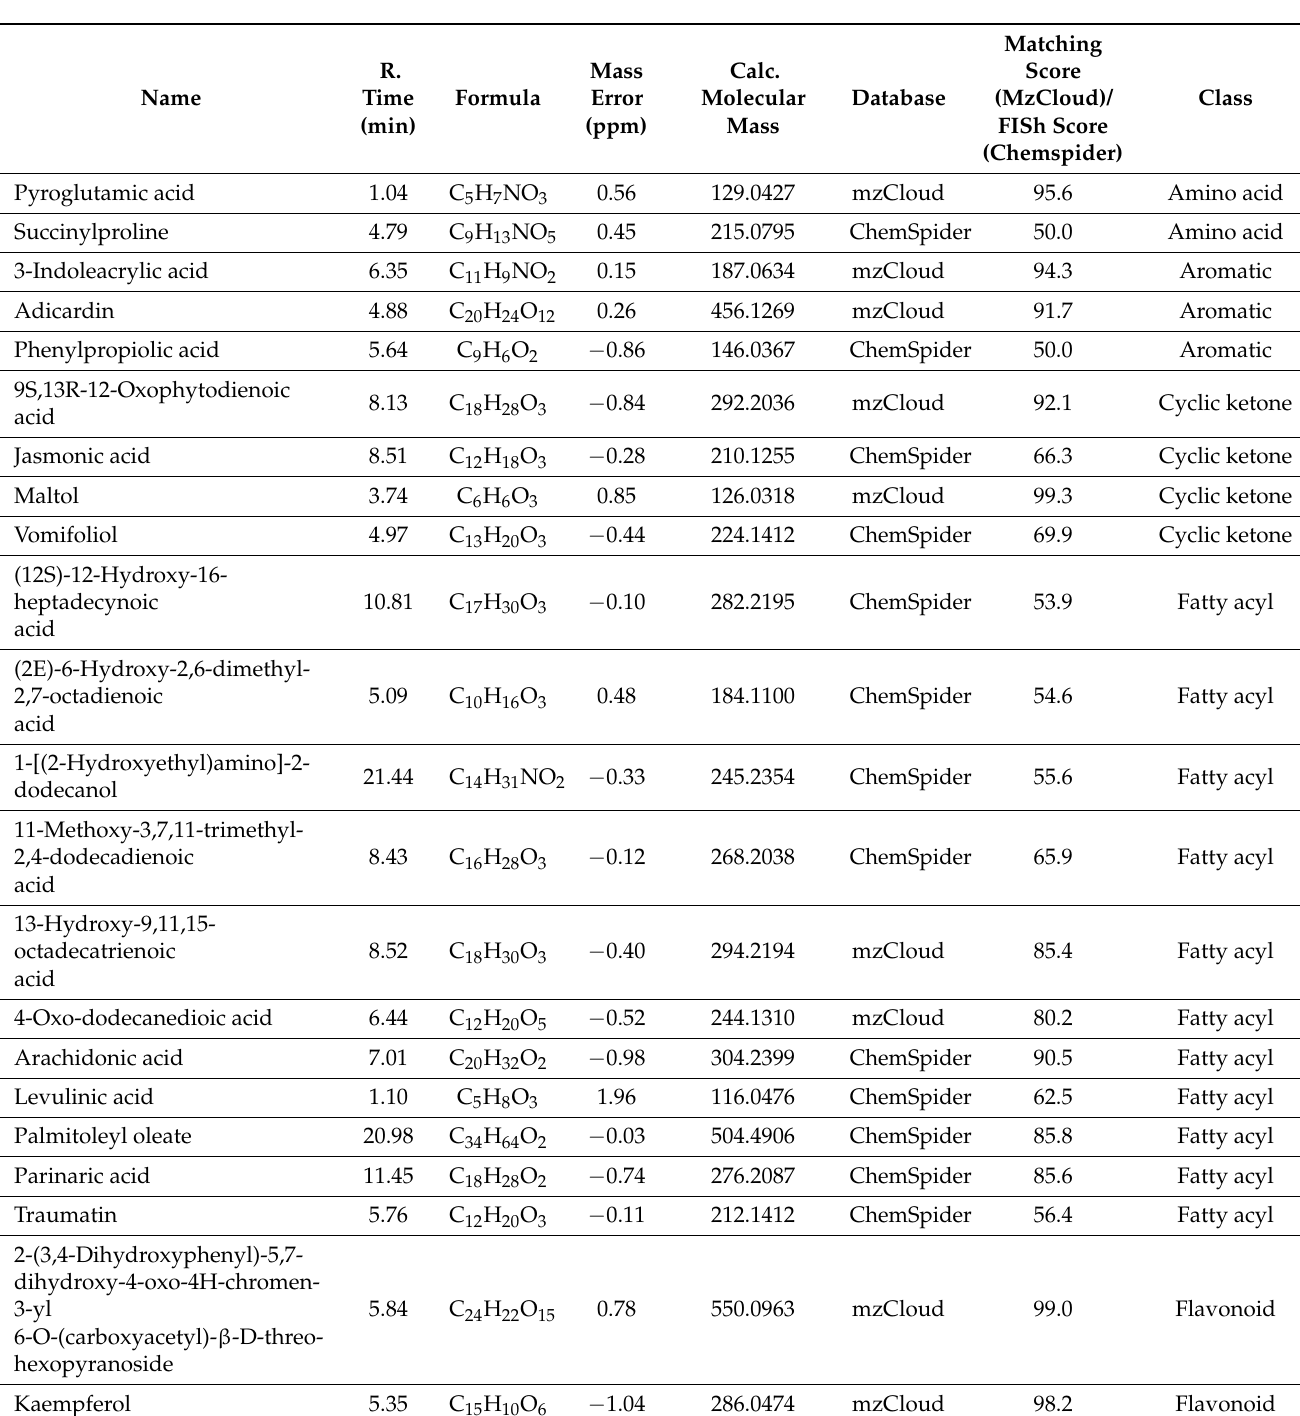
Table 1. Compounds identified in LM aqueous extract by positive mode of